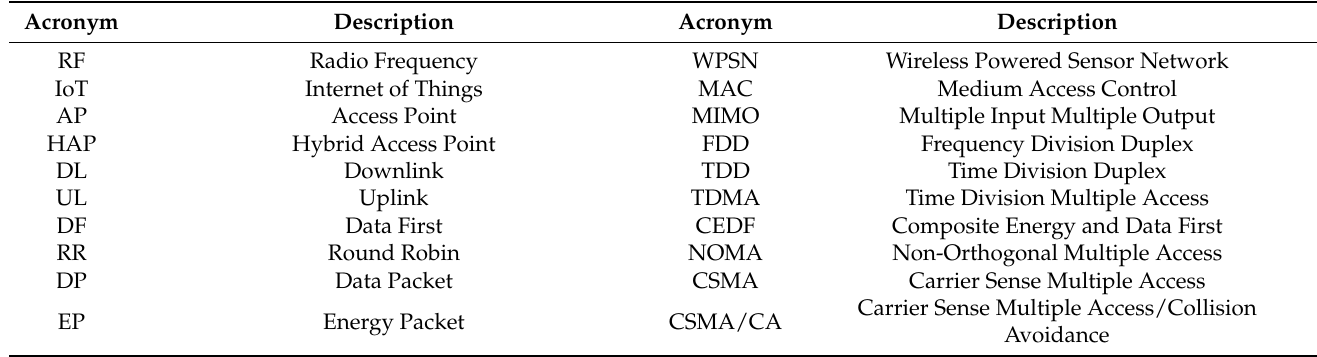
Table 1. Listing of acronyms with